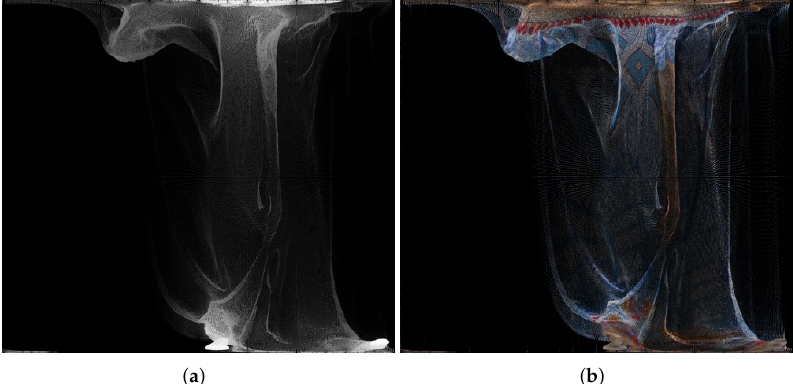
Figure 4. Panorama images created using point cloud “longdress_vox10_1060.ply” from the cylindri- cal equal-area projection, for the geometry ( a ) and texture ( b